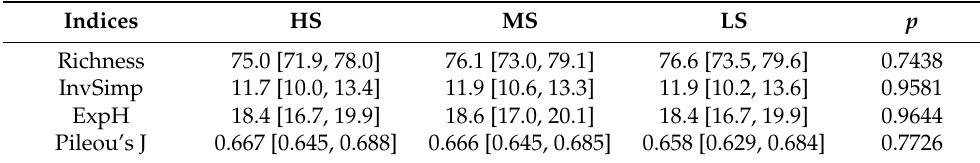
Table 5. Estimated mean (and [95% confidence interval]) alpha diversity indices for richness, inverse simpson, exponent shannon and Pileou’s evenness (J) of the microbiota of dogs ( n = 24) fed diets produced at high, medium and low shear (HS, MS and LS,